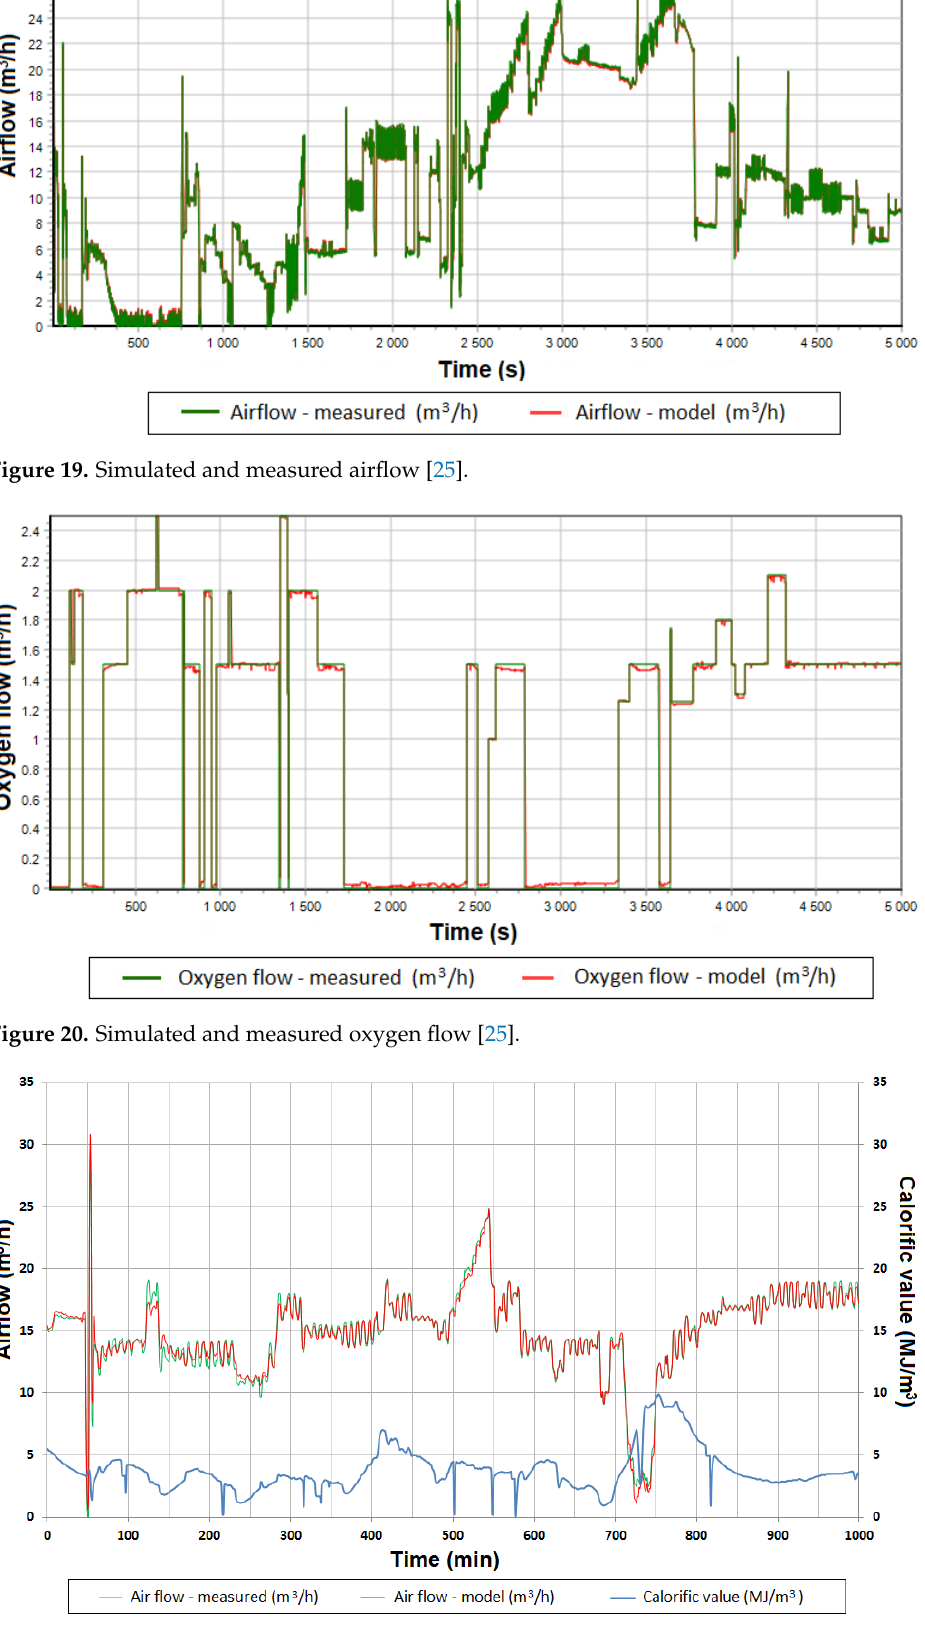
Figure 21. Control with continual identification during the UCG trial